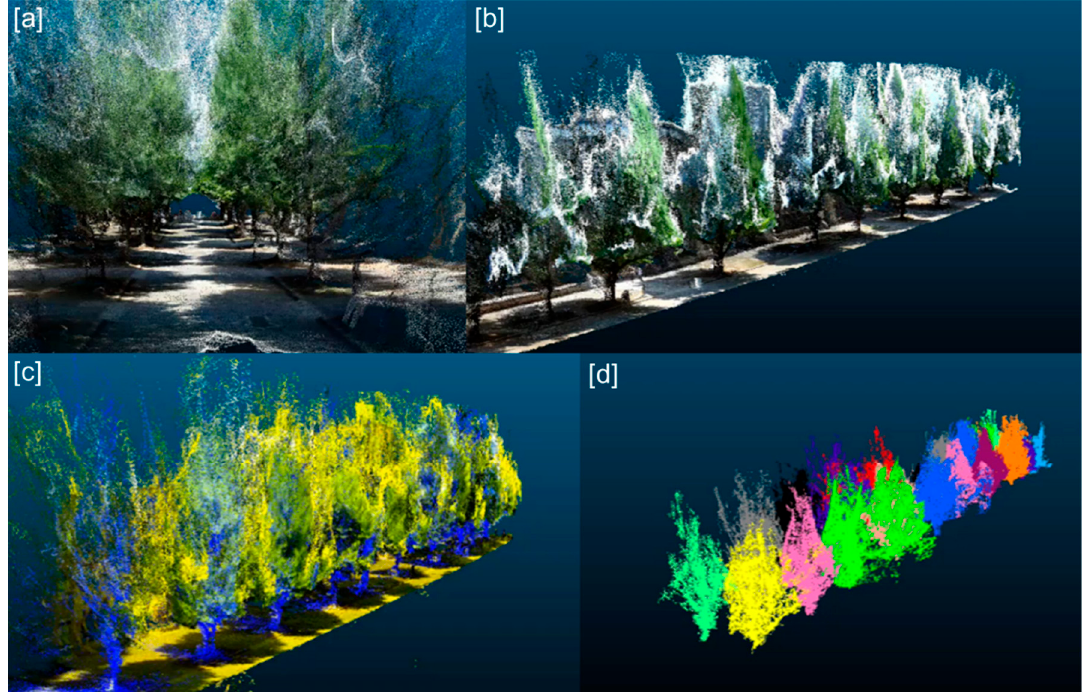
Figure 11. Result of tree detection in 3D images reconstructed by SfM (structure from motion). Panels ( a ) and ( b ) represent 3D images constructed from a 360° spherical camera. Panel ( c ) illustrates the 3D image containing tree information obtained by YOLO v2 detector. The points corresponding to trees are indicated in blue. This 3D image underwent post-processing, and each tree could be segmented, as shown in panel ( d ). Each tree is illustrated by a different color.